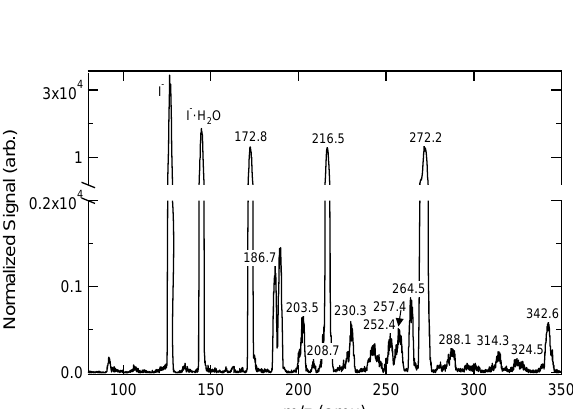
Figure 6. Aerosol-CIMS spectra of atomized solutions of 2 M formaldehyde/MG (1:1) in 3.1 M Fig. 6. Aerosol-CIMS spectra of atomized solutions of 2M AS. See the text for details of sample preparation and analysis. Negative-ion mass spectrum formaldehyde/MG (1:1) in 3.1MAS. See the text for details of sam- obtained using I - as the reagent ion. ple preparation and analysis. Negative-ion mass spectrum obtained using I − as the reagent